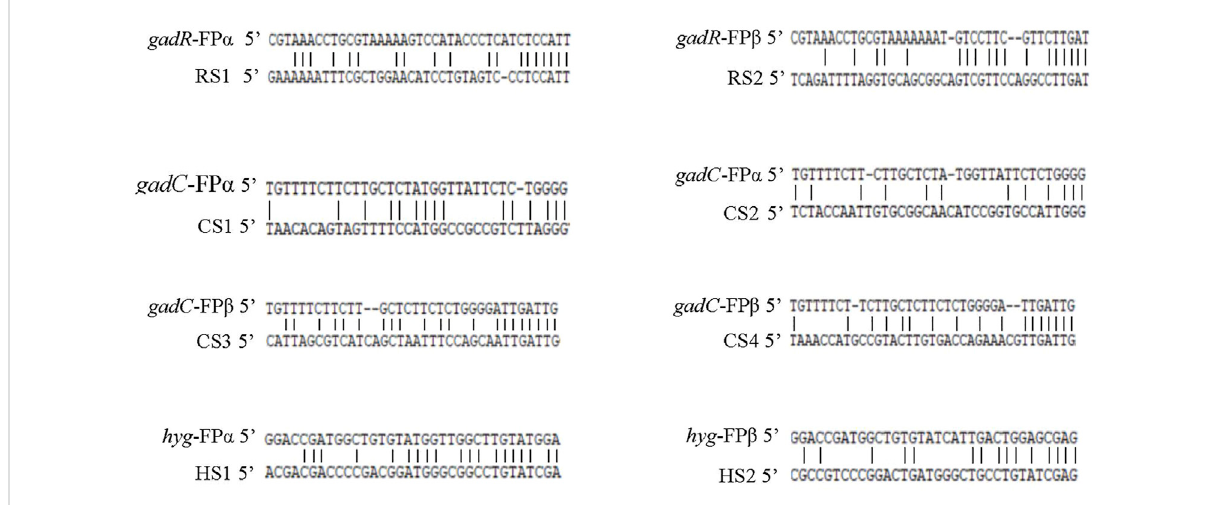
FIGURE 2 Partialannealinglociofthefusionprimers.Theupperandlowersequencesarethefusionprimerandannealingsite,respectively.RS1-RS2,CS1- CS4, and HS1-HS2 correspond to the DNA bands described in Figure 1.